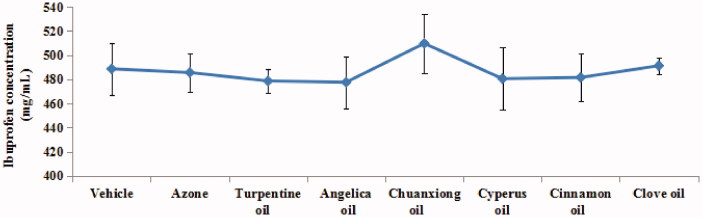
Solubility of ibuprofen with the presence of different EOs (n = 3). Note: vehicle = propylene glycol (PG): isopropyl alcohol (IPA) (3:7, v/v).